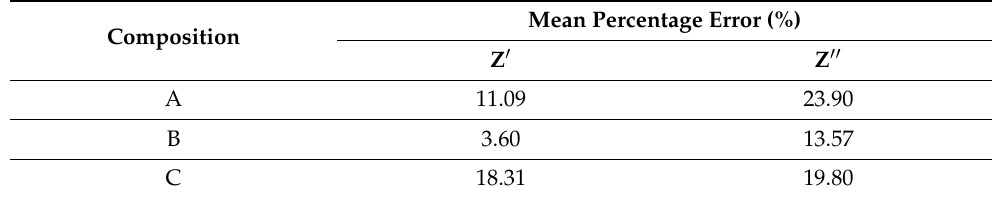
Table 4. Components values of the lumped-element circuit (Figure 3) for scaffold composites of Wangi rice starch and nHA at X-band.